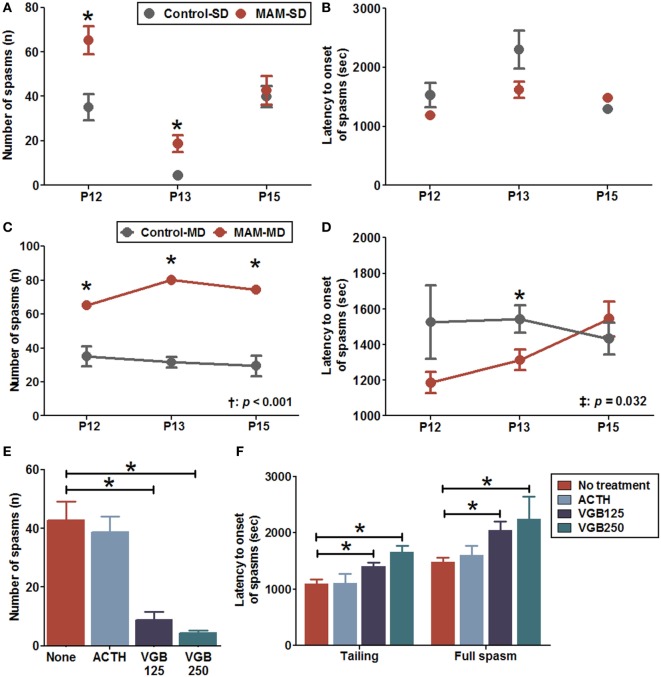
Enhanced NMDA-induced spasm susceptibility and effects of anti-epileptic drugs in prenatally MAM-exposed infant rats treated with single (SD) or multiple (MD) N-methyl-d-aspartate (NMDA) doses. (A) MAM-exposed rats (MAM-SD, n = 15 at postnatal day (P) 12, n = 8 at P13, n = 10 at P15) showed significantly increased numbers of spasms in response to single NMDA doses at P12 (65.3 ± 6.2 vs. 35.1 ± 5.9, p = 0.003) and P13 (18.8 ± 3.8 vs. 4.4 ± 1.2, p = 0.002) compared to prenatally saline-exposed rats (control-SD, n = 9 at P12, n = 8 at P13, n = 6 at P15). (B) The latency to onset of spasms did not differ significantly between MAM and control groups treated with a single NMDA dose. (C) MAM-exposed rats exhibited significantly greater numbers of spasms in response to repeated NMDA administration on P12, P13, and P15 (MAM-MD, n = 15; 65.3 ± 6.2 at P12, p = 0.003; 80.1 ± 7.2 at P13, p = 0.001; 74.5 ± 10.1 at P15, p = 0.002) compared to prenatally saline-exposed rats (control-MD, n = 9, 35.1 ± 5.9 at P12, 31.7 ± 3.2 at P13, 29.6 ± 6.0 at P15). The number of spasms differed significantly between the control and the MAM groups over time (p < 0.001). (D) The latency to onset of spasms was significantly shorter in MAM rats than in controls with a significant group × time interaction (p = 0.032). The mean latency to onset of spasms in the MAM-MD group at P13 (1,313.7 ± 57.6 s) was significantly shorter than that in the control-MD group (1,543.8 ± 78.3 s, p = 0.03). (E) In MAM-SD rats, vigabatrin (VGB) significantly reduced the number of spasms at 125 mg/kg (VGB125, n = 11, 8.8 ± 2.6, p < 0.001) and 250 mg/kg (VGB250, n = 8, 4.3 ± 1.0, p < 0.001) compared to VGB-naïve MAM group rats (n = 10, 42.7 ± 6.4). (F) Pretreatment with VGB125 and VGB250 significantly prolonged the mean latency to onset of tailing (VGB125, 1,404.8 ± 70.5 s, p = 0.01; VGB250, 1,660.4 ± 113.8 s, p = 0.001) and first full spasms (VGB125, 2,047.8 ± 153.5 s, p = 0.012; VGB250, 2,246.9 ± 398.3 s, p = 0.016) compared to VGB-naïve MAM group rats (tailing, 1,091.5 ± 80.7 s; first full spasm, 1,480.9 ± 82.1 s) dose-dependently. In contrast, adrenocorticotropic hormone (ACTH, n = 6) had little effect on the number of spasms and the latency to onset of spasms. Values expressed as mean ± SEM. *p < 0.05 using Mann–Whitney U test for comparison between the two groups. †p < 0.05 using repeated measure ANOVA for main effect of group (between group) on the number of spasms or the latency to onset of spasms. ‡p < 0.05 using repeated measure ANOVA for interaction effect of time-by-group on the number of spasms or the latency to onset of spasms.